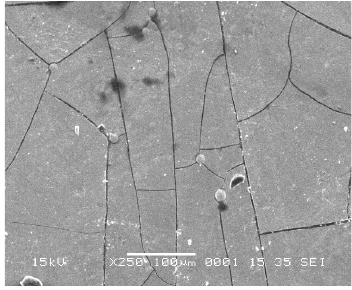
Figure 4. SEM image of nickel coating on mild